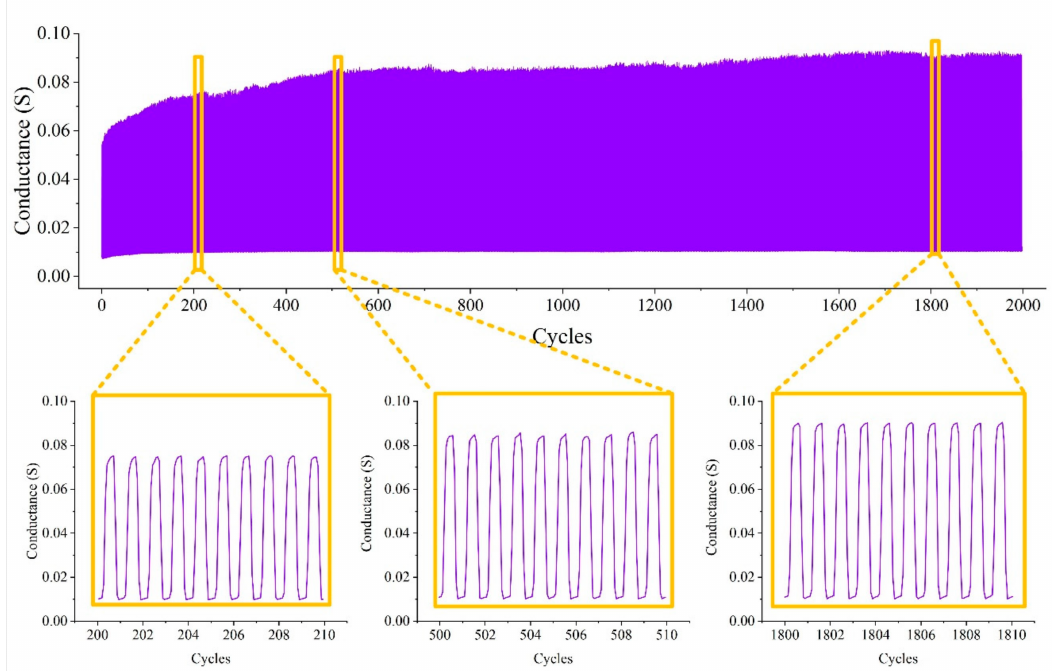
Figure 11. Durability test